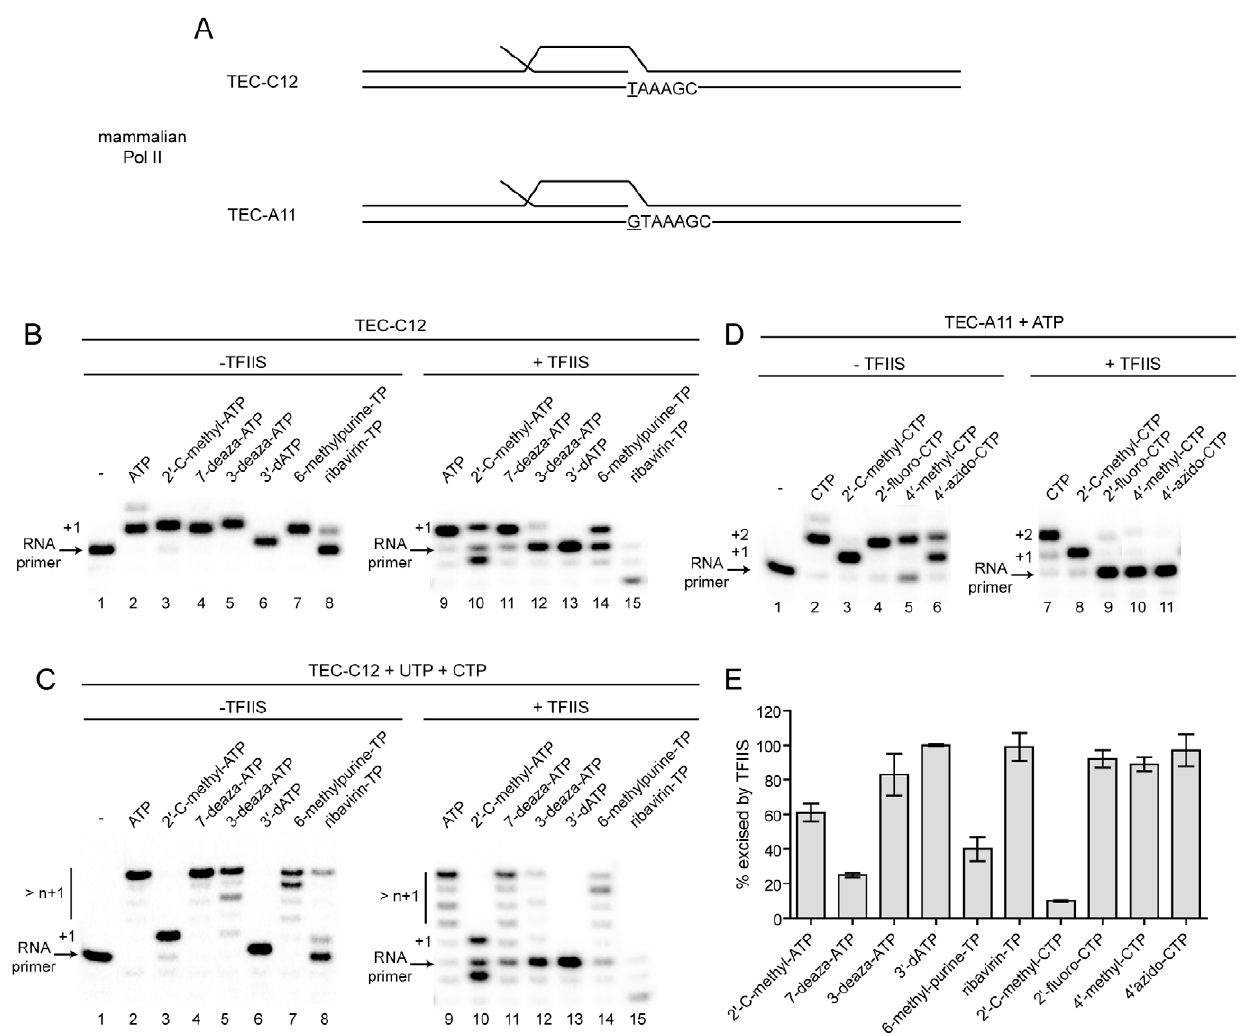
Figure 3. TFIIS prevents accumulation of antiviral nucleotides in Pol II transcripts. ( A ) Schematic of synthetic nucleic scaffolds for transcription elongation complex (TEC) assembly with calf thymus Pol II. The first templating base is underlined. The TEC with 11-nt RNA (TEC-A11) was assembled using TDS50, NDS50 and RNA9 (see Table S2 for the complete oligonucleotide sequences) in the presence of 10 m M each GTP and ATP (TEC-A11) and purified from the unincorporated DNA, RNA and NTPs; TEC-C12 was obtained by addition of 10 m M CTP to TEC-A11. ( B ) Reaction products from Pol II-catalyzed nucleotide incorporation in the absence and presence of TFIIS. The concentration of unmodified substrate NTP and analogs were 500 m M; TFIIS was added at 10 m M. Reactions proceeded for 2 min. Reactions with ribavirin-TP proceeded for 10 min. ( C,D ) Reaction products from Pol II-catalyzed nucleotide incorporation in the presence of the next correct nucleotide substrate. The concentration of the unmodified substrate NTP and analogs were 500 m M; TFIIS was added at 10 m M. Reactions proceeded for 2 min. Reactions with ribavirin-TP, 4 9 -methyl-CTP and 4 9 -azido-CTP proceeded for 10 min. ( E ) Percent inhibition by TFIIS on Pol II nucleoside analog incorporation.